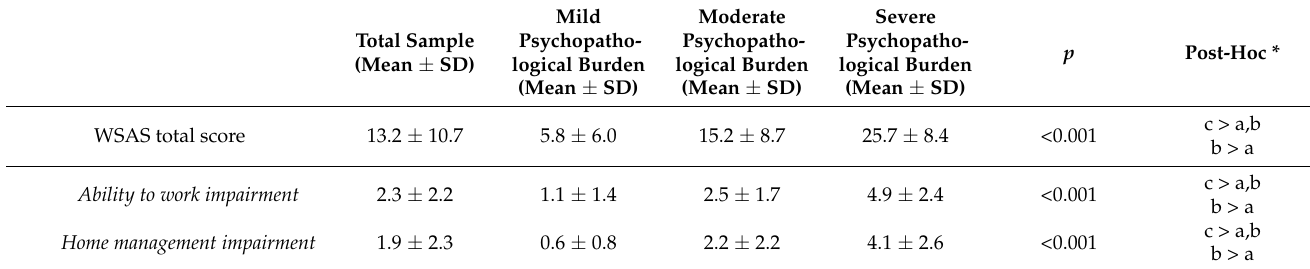
Table 5. Comparison of WSAS and ProQOL-5 scores in the total sample ( n = 139) and in the Mild psychopathological burden ( n = 62), Moderate psychopathological burden ( n = 49) and Severe psychopathological burden ( n = 28)